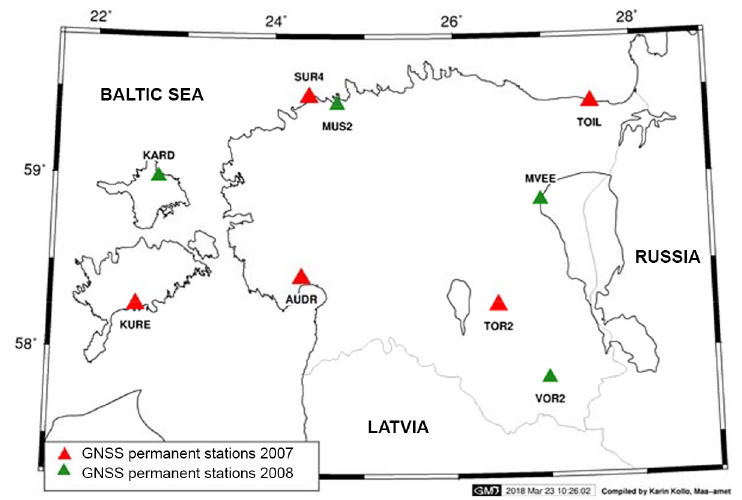
Figure 2. Estonian GNSS reference stations by the end of